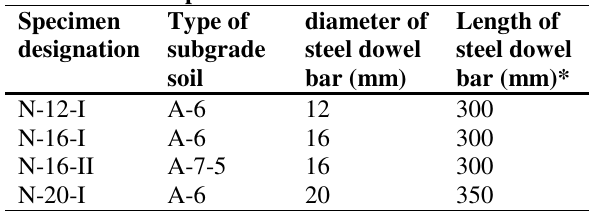
Details of the Specimens